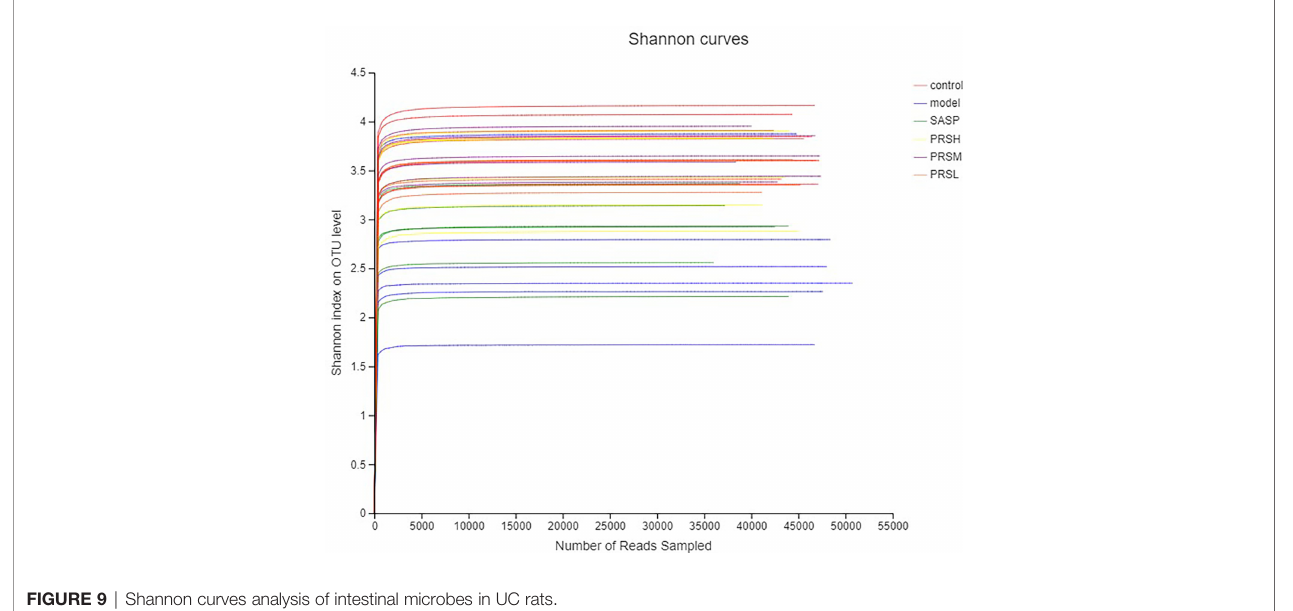
FIGURE 9 | Shannon curves analysis of intestinal microbes in UC rats.